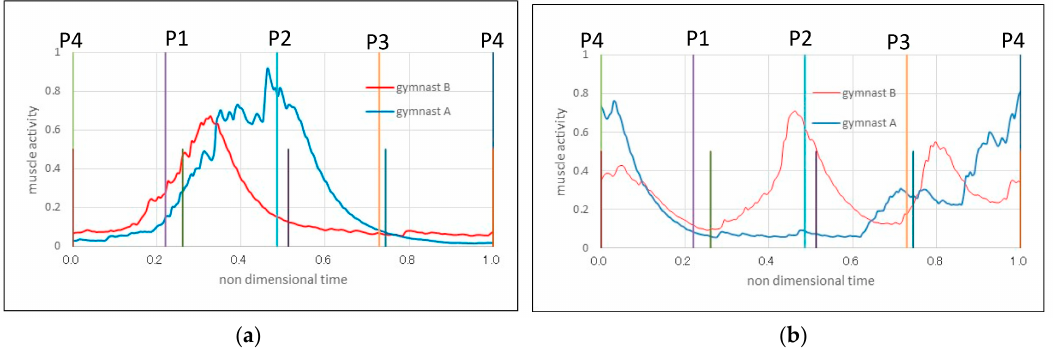
Figure 5. Muscle activity of the external oblique muscle of Gymnasts A and B. ( a ) Left side; ( b ) Right